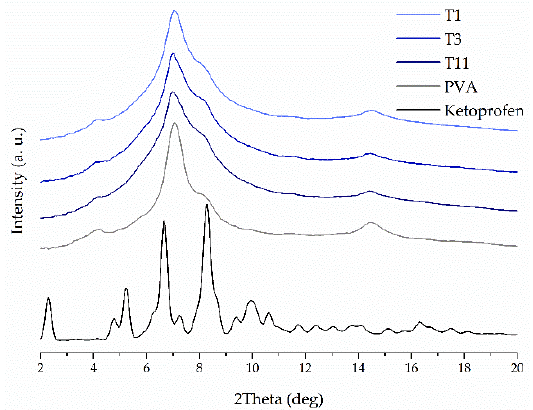
Figure 3. XRPD diffraction patterns of neat KET, neat PVA, and 3DP tablets made from filaments containing 20%, 40%, or 50% of KET with the addition of crospovidone.